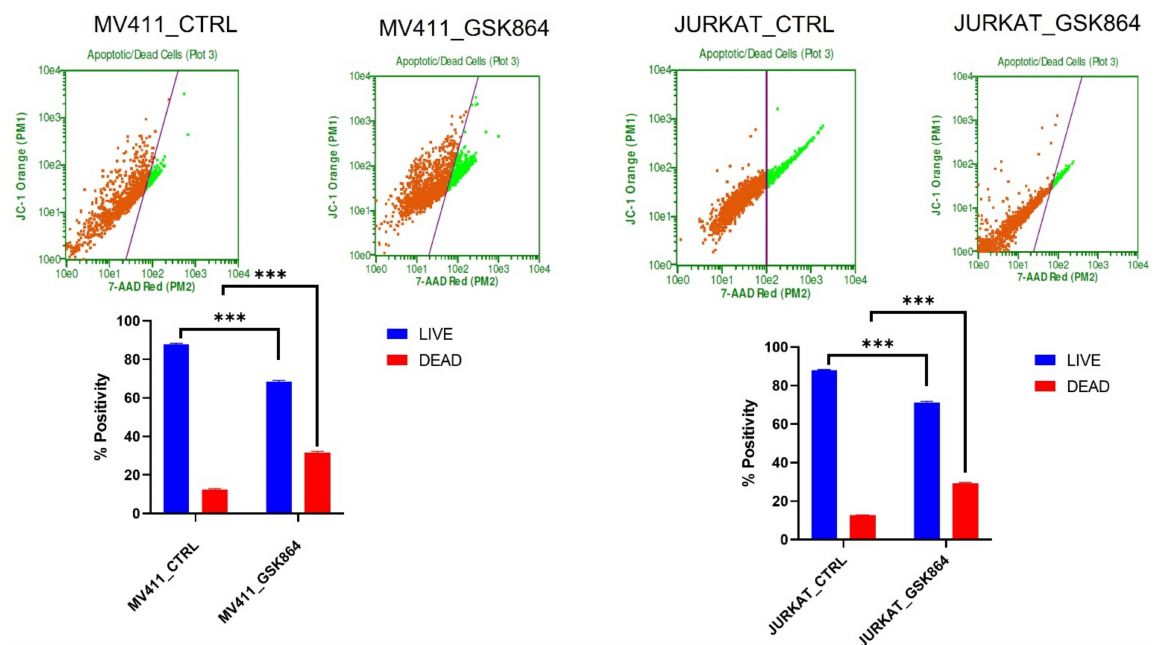
Figure 8. IDHi induced cell death in leukemic cells. The live and the dead assays were performed in control and GSK864-treated leukemic cells; *** p <